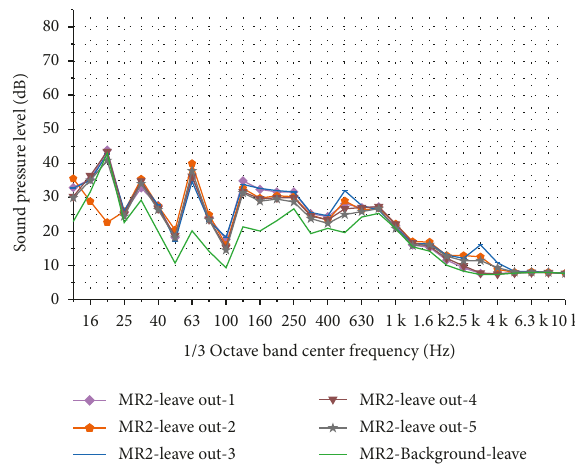
Figure 11: 1/3 octave frequency spectrum for measurement points MS3.